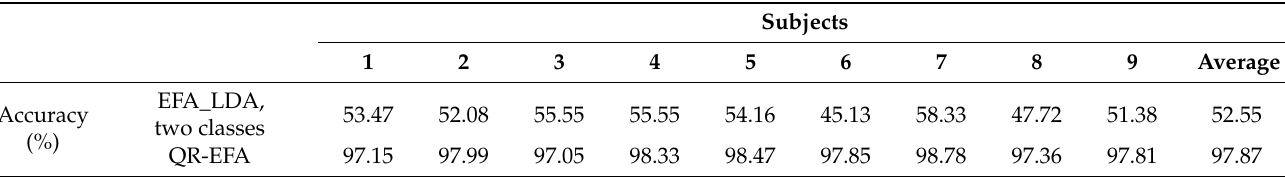
Table 4. EEG analysis accuracy for C4D2a_4C, using QR-EFA method.